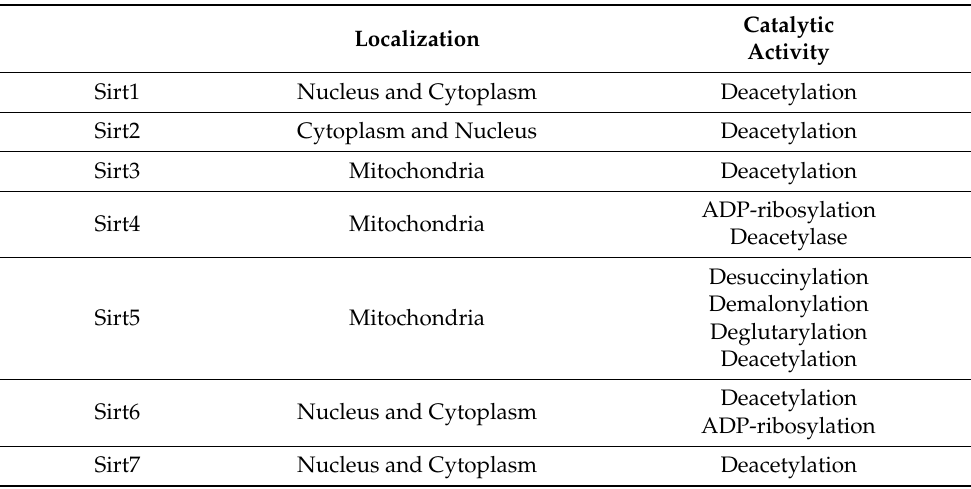
Table 1. Mammals have seven sirtuins, each with a predominant subcellular localization and a different catalytic activity. Catalytic Localization Activity Sirt1 Nucleus and Cytoplasm Deacetylation Sirt2 Cytoplasm and Nucleus Deacetylation Sirt3 Mitochondria Deacetylation ADP-ribosylation Sirt4 Mitochondria Deacetylase Desuccinylation Demalonylation Sirt5 Mitochondria Deglutarylation Deacetylation Deacetylation Sirt6 Nucleus and Cytoplasm ADP-ribosylation Sirt7 Nucleus and Cytoplasm